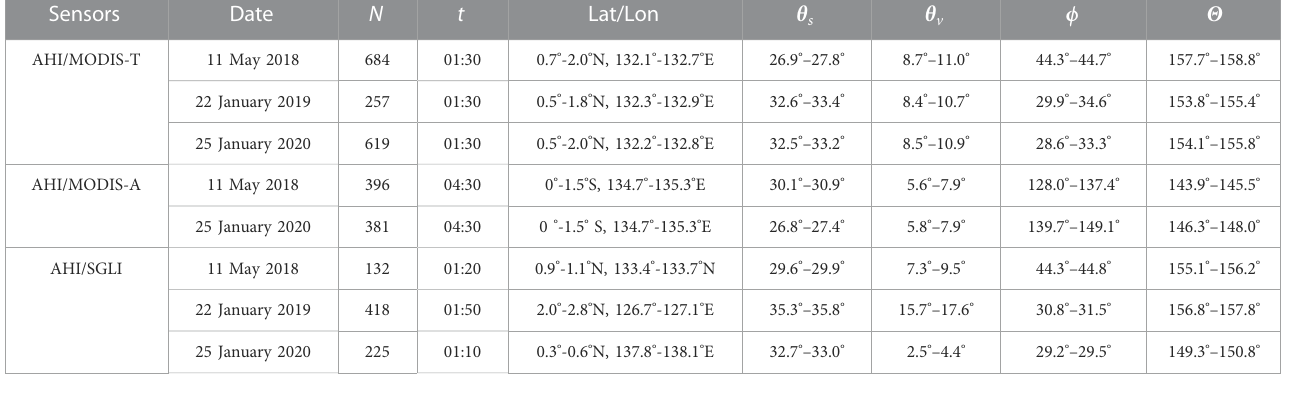
TABLE 4 The observation time ( t , GMT), geometry (solar zenith θ s , view zenith θ v , relative azimuth ϕ , and scattering angle Θ ), latitude/longitude, and total number of collocated pixels N) for each sensor pair on the three different dates. Sensors